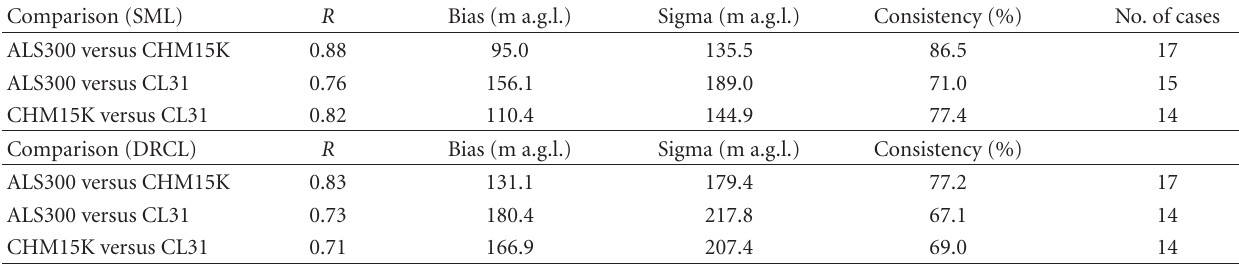
Table 1: Mean statistical parameters of the ALS300-CHM15K-CL31 intercomparison. For each X versus Y comparison, R is the correlation coe ffi cient, bias = abs ( Y - X ), Sigma = std ( Y - X ), and consistency is percentage of X versus Y detection closer than 200m, that is, abs ( Y - X ) ≤